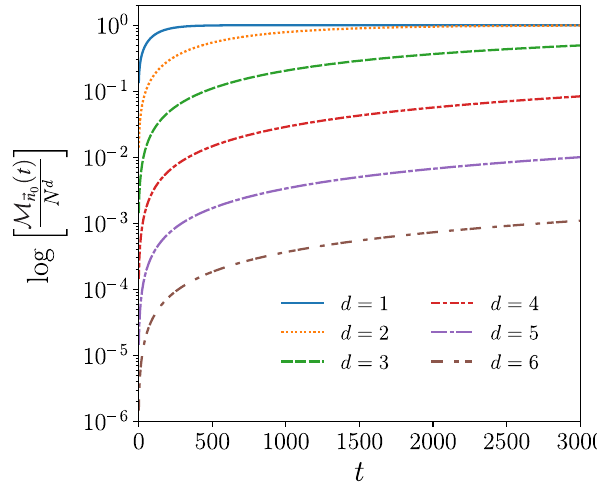
FIG. 4. Time dependence of the average number of distinct visited sites in a box (with reflective boundary conditions along each side) of size N d . The 1D case is plotted by using Eq. (D1), while all the remaining ones are obtained through a numerical z inversion of Eq. (12). The starting location, for i ¼ 1 ; … ; d , is at 1 , and q 2 d= ð 2 d þ 1 Þ so that in any dimension the n 0 i ¼ i ¼ transition probabilities at each time step to move to either P d = ð 2 d Þ , or to stay, 1 − q = ð d Þ , are of the adjacent sites, q i i i ¼ 1 all identical, and equal to 1 = ð 2 d þ 1 Þ , when away from the